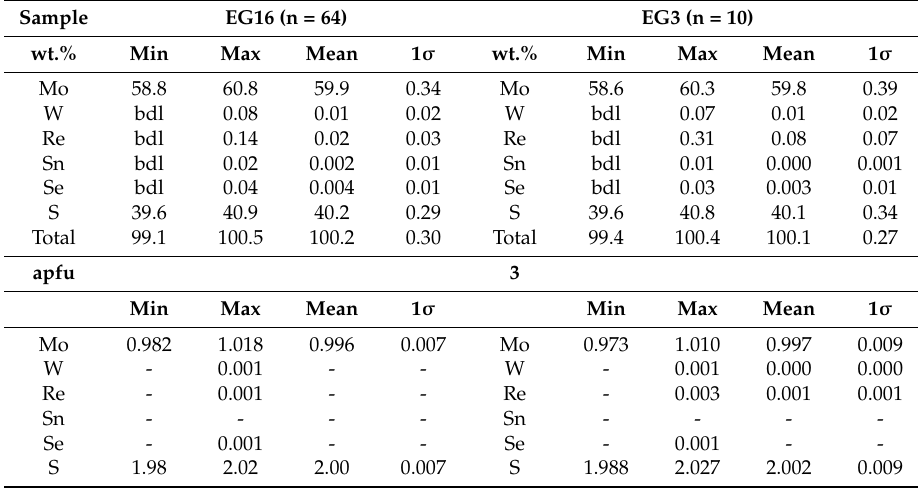
Table 3. EPMA data of molybdenite from porphyry-style mineralization of the Aisymi-Leptokarya